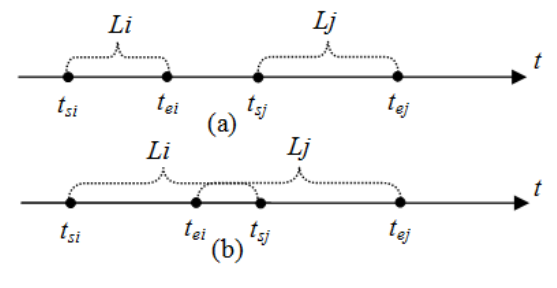
Figure 3. Time interval of different